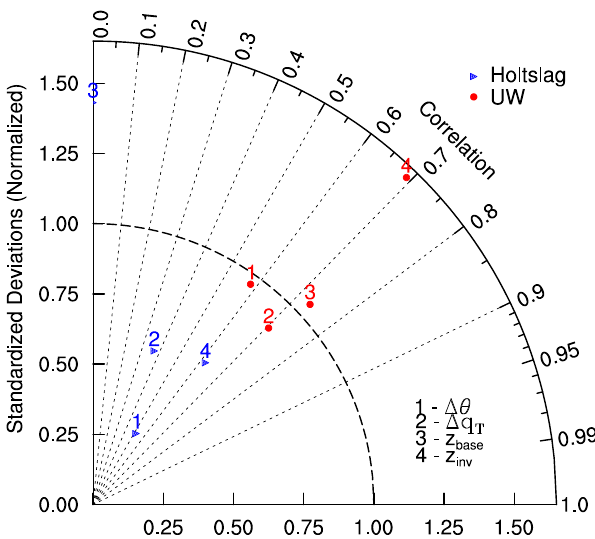
Fig. 9. A Taylor diagram comparing the representation of day-to- day variations in boundary layer properties in the UW and Holt- slag model runs (red-filled circles and blue triangles, respectively) against DYCOMS II, POST, and VOCALS in situ data. Correlations and ratios of standard deviations are depicted for the following vari- ables: boundary layer inversion strength ( 1θ ), jump in water vapor mixing ratio at cloud top ( 1q T ), cloud base height ( z base ), and in- version height ( z inv